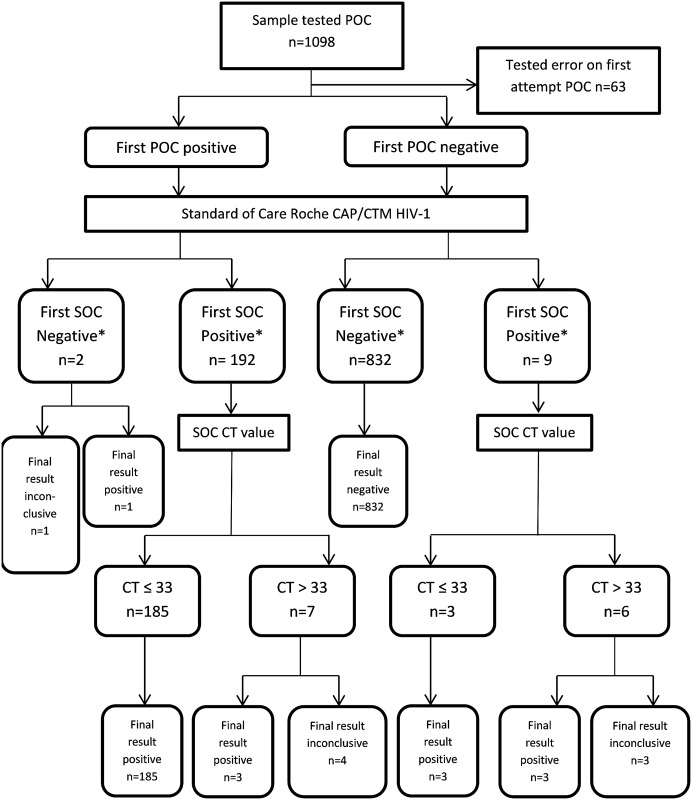
STARD diagnostic study flow diagram.The POC diagnostic accuracy analyses take into account 1) the result of first SOC test result* which is a direct comparison between the qualitative output of SOC and POC assay according to the manufacturer’s instructions. 2) Final test result which used the best result following retest for any inconclusive SOC result (CT > 33) and any discordant SOC/POC results. If an infant is conclusively positive on SOC assay in another sample, or positive on two different nucleic acid tests, the infant is considered positive in final result. Otherwise his/her final result is considered inconclusive.